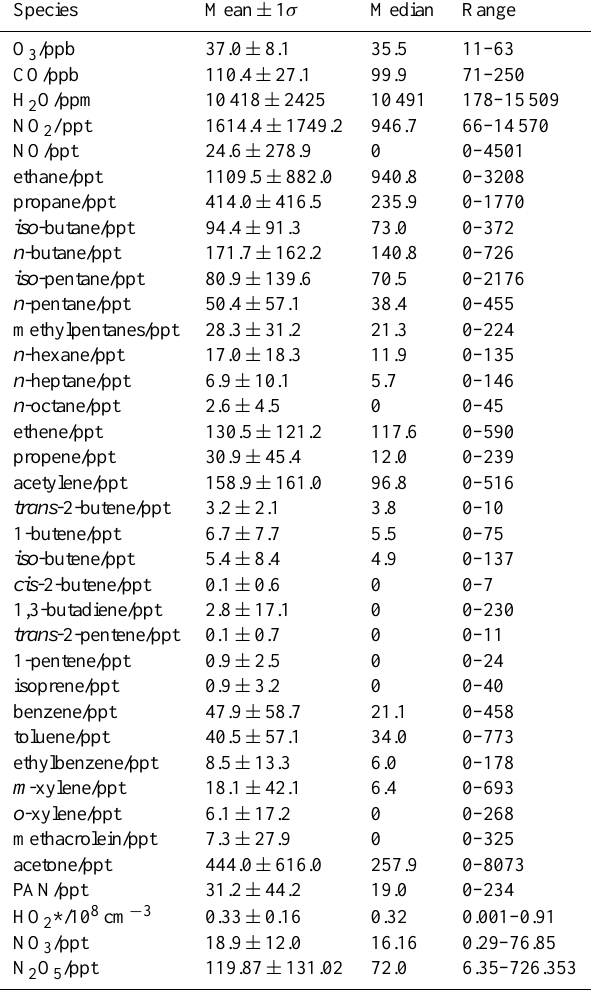
Table 2. Summary of observations used to constrain the model in this work and, in the case of HO 2 *, NO 3 and N 2 O 5 , to compare with model calculations. Zero values indicate measurements below the instrumental limits of detection.